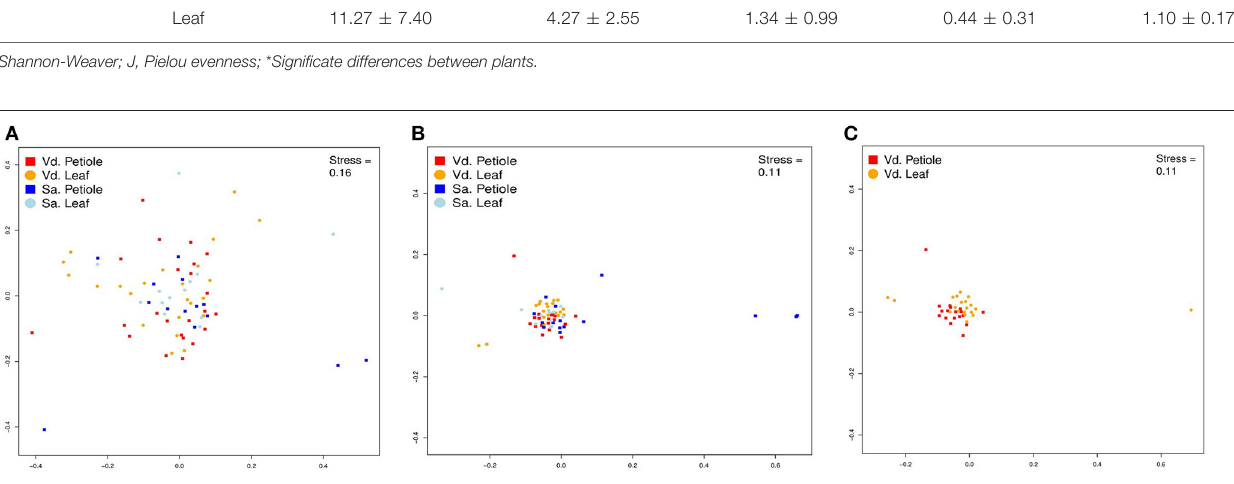
72%) and in CY medium (IG: 59%) and the extract from Epicoccum sp.2 LGMF1600 in ME medium (IG: 40%). In the other hand, the extracts from Diaporthe cf. heveae